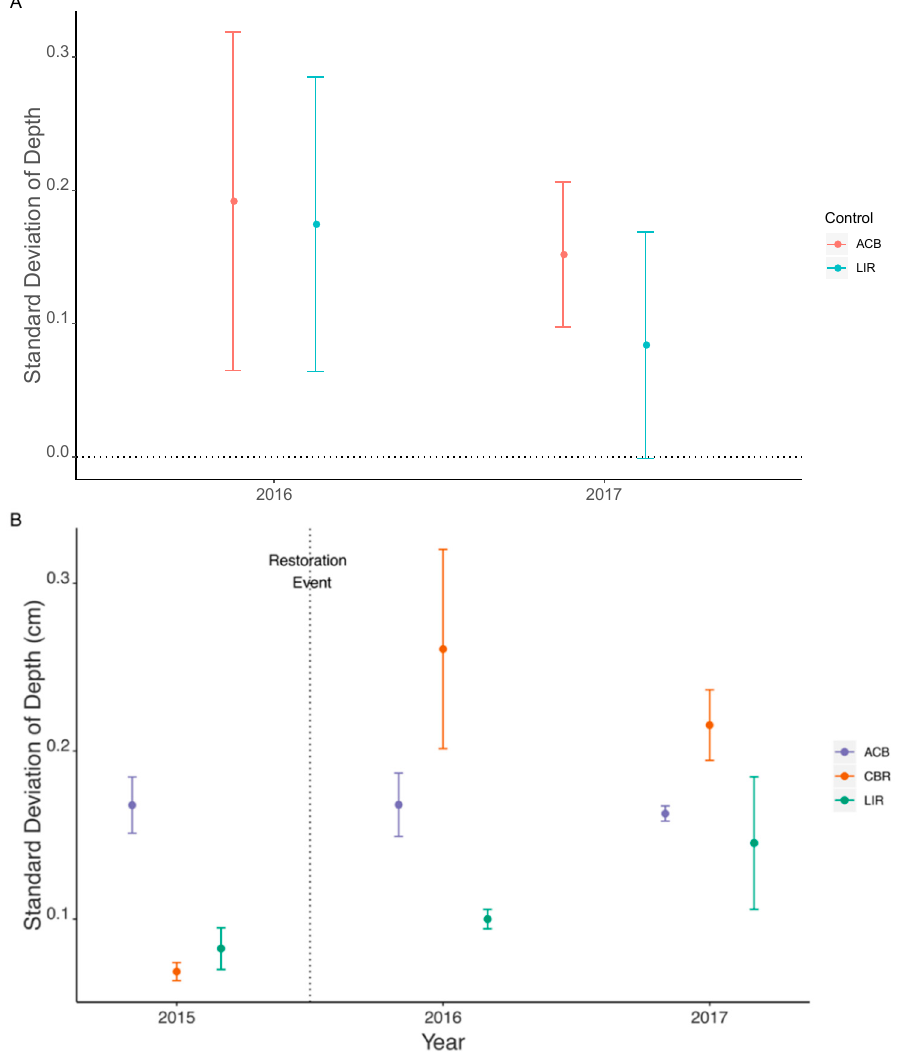
Figure 6. Standard deviation of depth (SD dep ) as given by BACI effect size ( A ) and actual values with standard error ( B ). Significant differences are noted by confidence interval range not overlapping zero ( A ) while all pairwise Welch’s t -tests are non-significant ( α = 0.008) between CBR and other treatments within each year ( B ). ACB = active cranberry bog, CBR = cranberry bog restoration, LIR = least impacted reference. All statistical comparisons are listed in Supplemental Table S4A and Supplemental Table S5B.